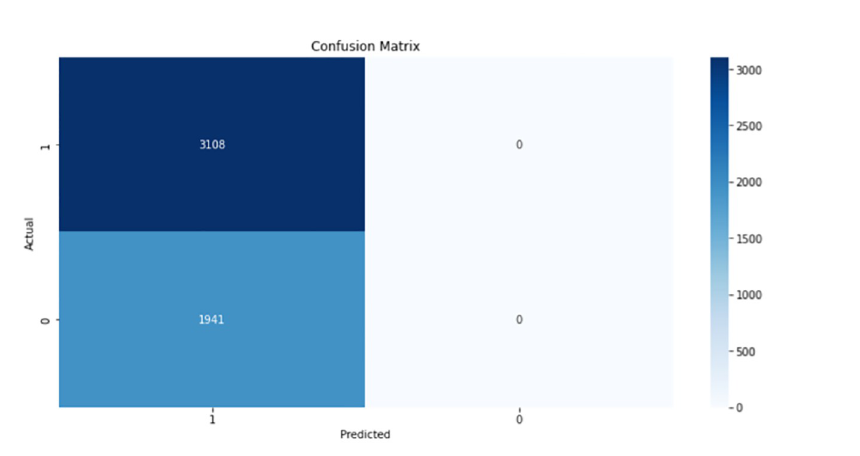
Fig 8. Confusion matrix of the GRU model for BRCA 2 .